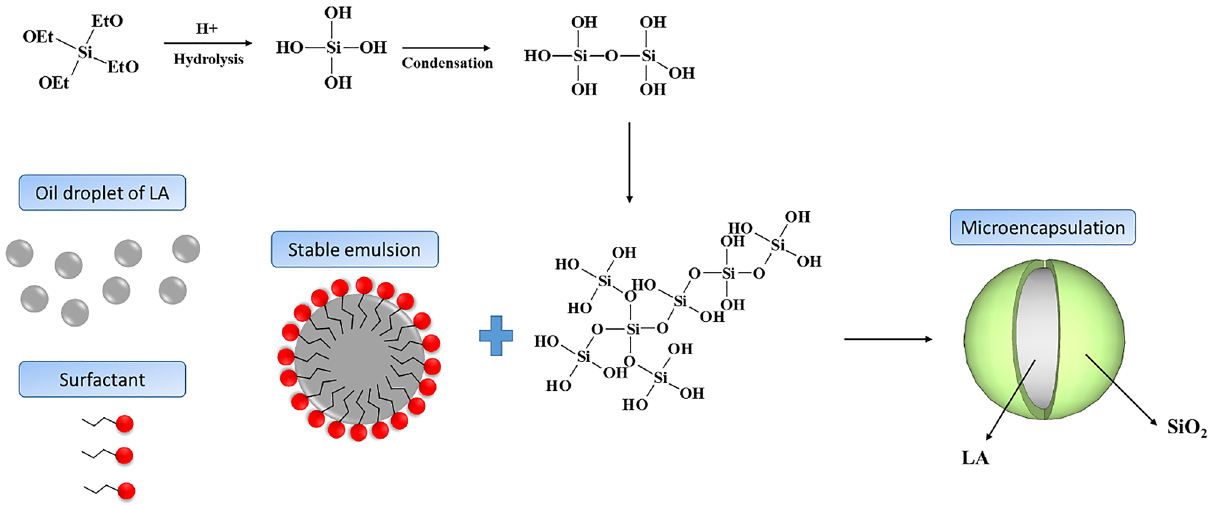
Figure 1. Schematic of the formation of microencapsulated LA with SiO 2